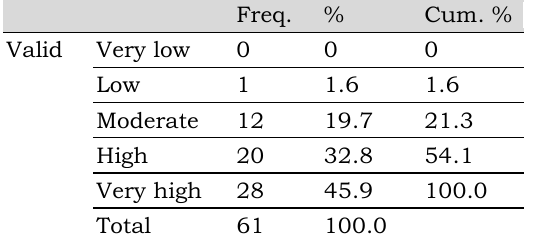
Table 2 . The respondents’ self-efficacy distribution Freq. % Cum.